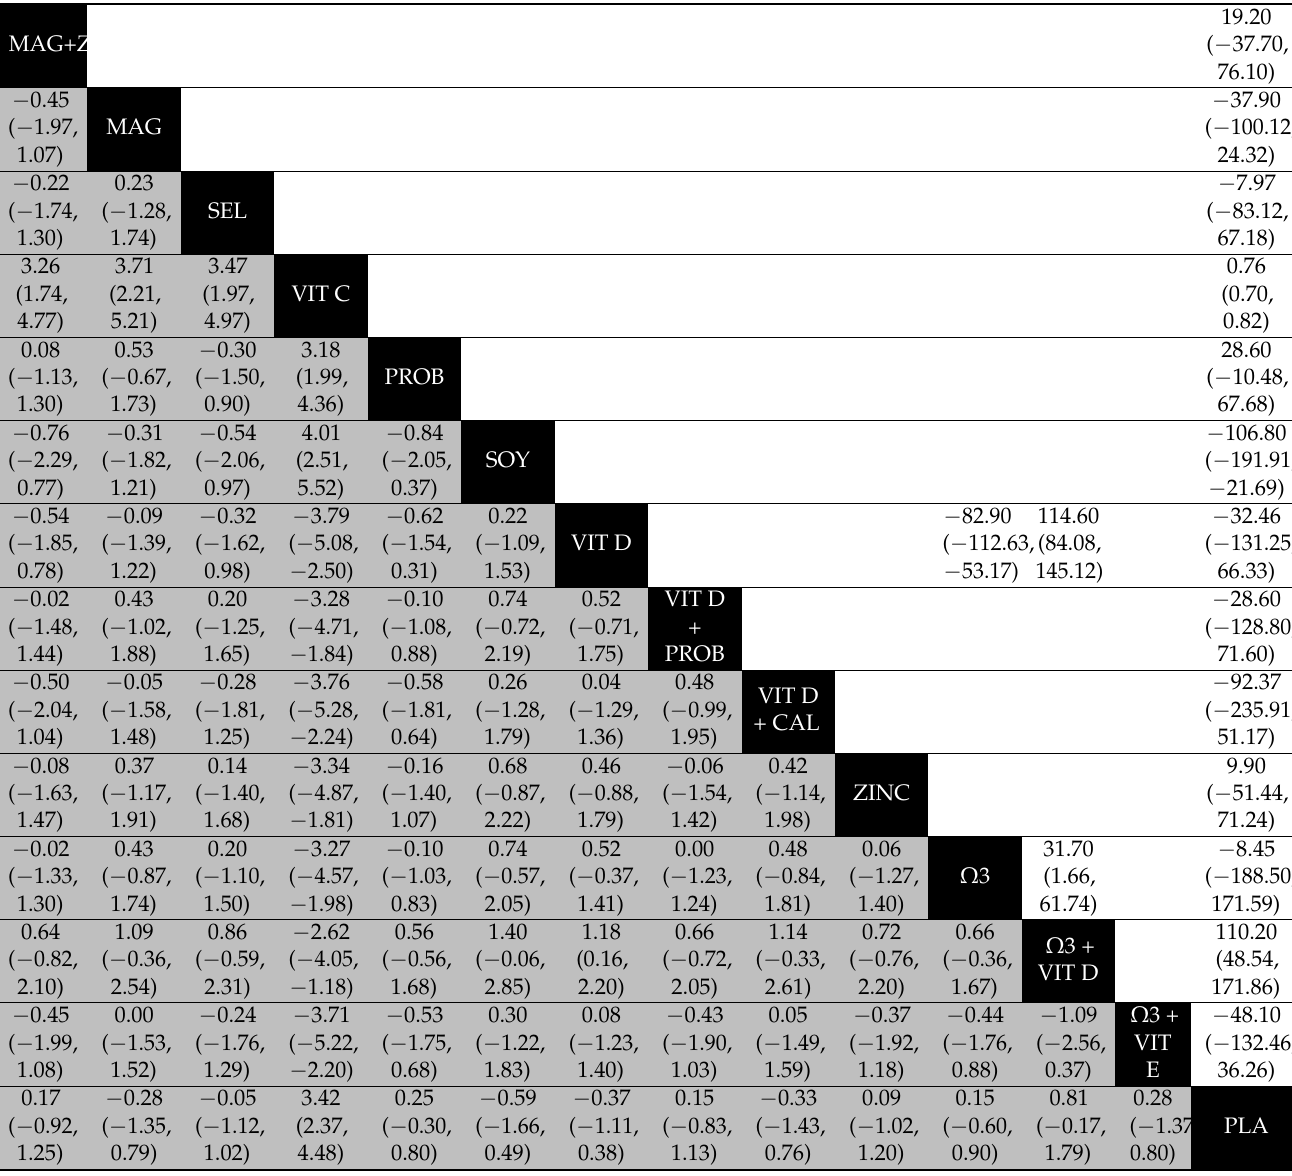
Table 8. Direct and indirect (in grey) estimates of the mean difference of GSH. Each column presents a different intervention.